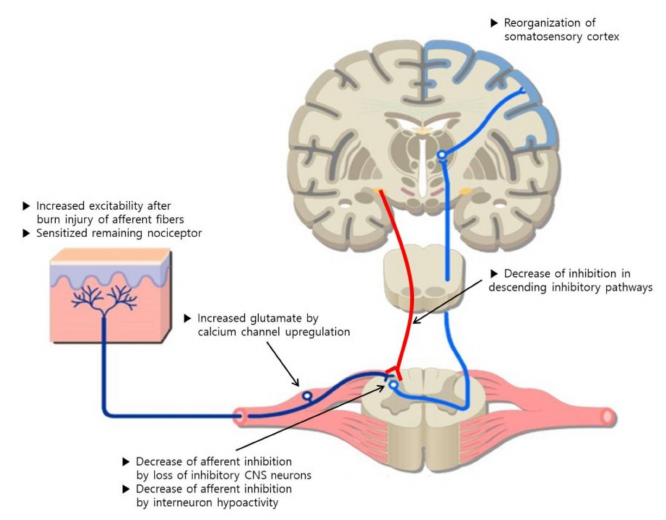
Figure 1. Mechanisms underlying post-burn neuropathic pruritus. Adapted from